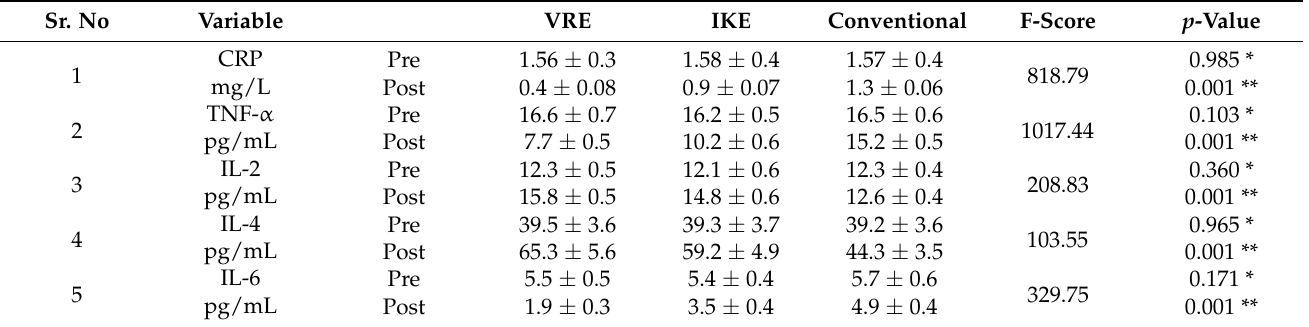
Table 3. Mean and SD of pre and post inflammatory biomarker measures of VRE, IKE, and conven- tional